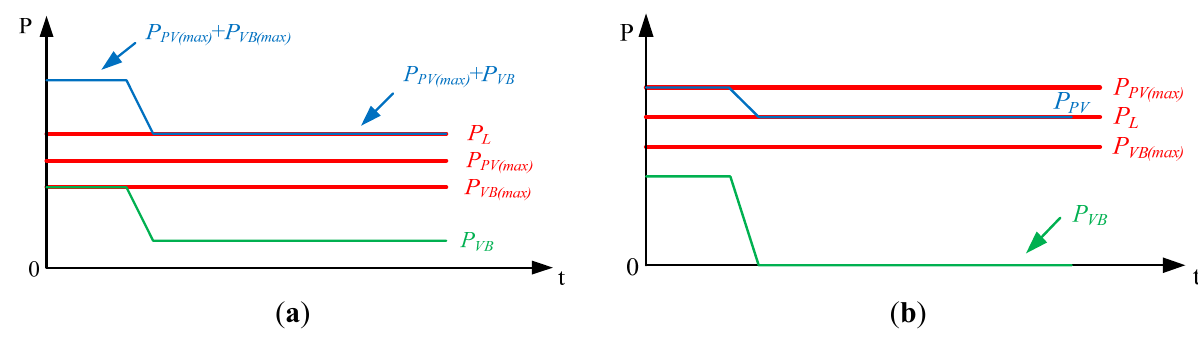
+ P ≥ P PV ( max ) VB ( max ) L